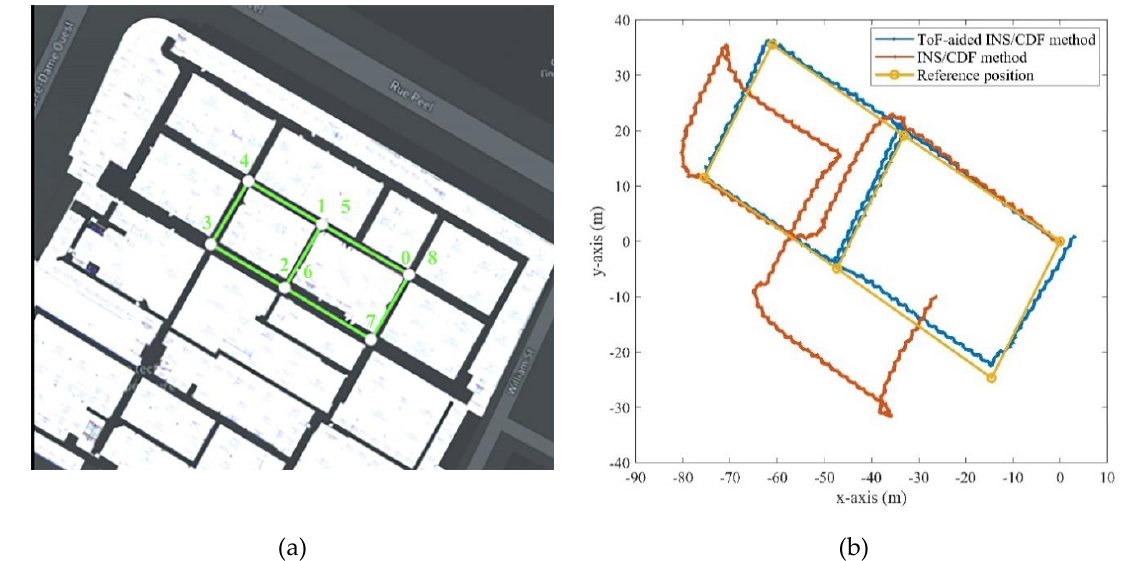
Figure 13. ( a ): The reference trajectory on the map of the building, ( b ): 2D results of the estimated position during the entire trajectory.